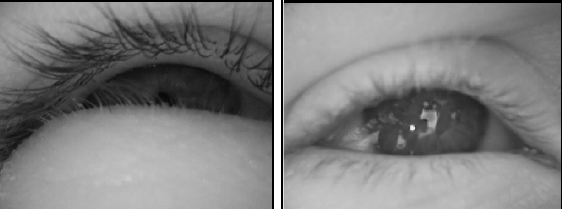
Figure 12. Challenges to pupil tracking in outdoor environments. Natural light can produce squinting that obstructs the pupil (left) and reflections that reduce the pupil’s relative darkness